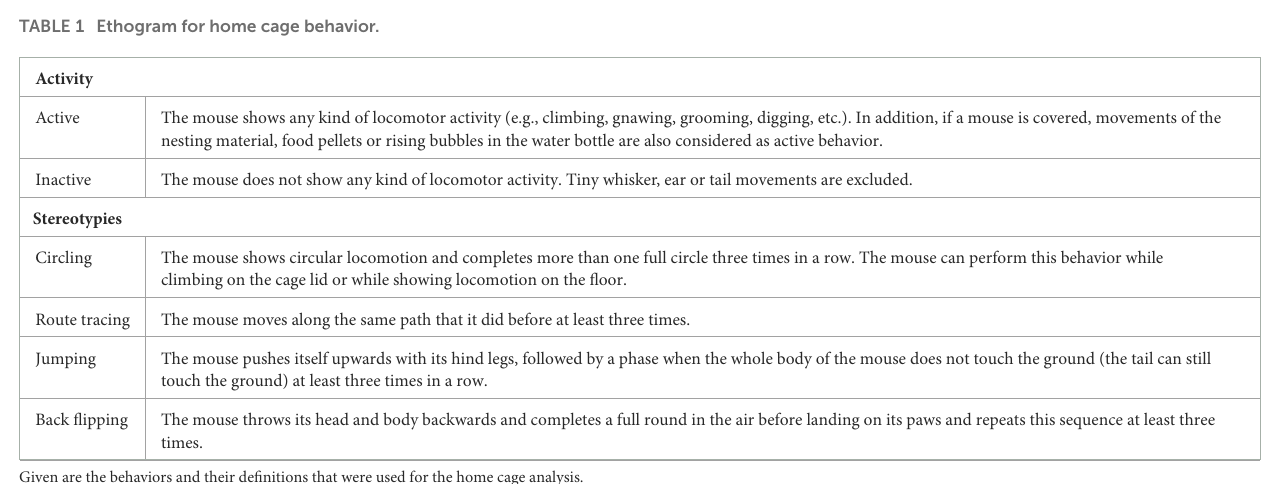
TABLE 1 Ethogram for home cage